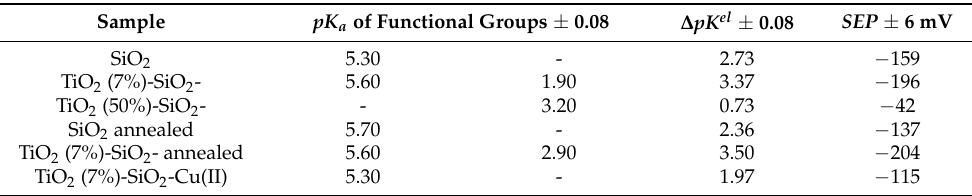
Figure 7. Experimental EPR titration curves for the NR at 293 K obtained by plotting the fast- and slow-motioned component of the EPR spectra of the NR in the non-protonated form ( f ) vs. pH ext in aqueous solution ( black squares ) and inside the TiO 2 (7%)–SiO 2 ( blue diamonds ), TiO 2 –SiO 2 –Cu(II) ( green triangles ), respectively. Table 2. Acid–base and electrosurface characteristics of the samples